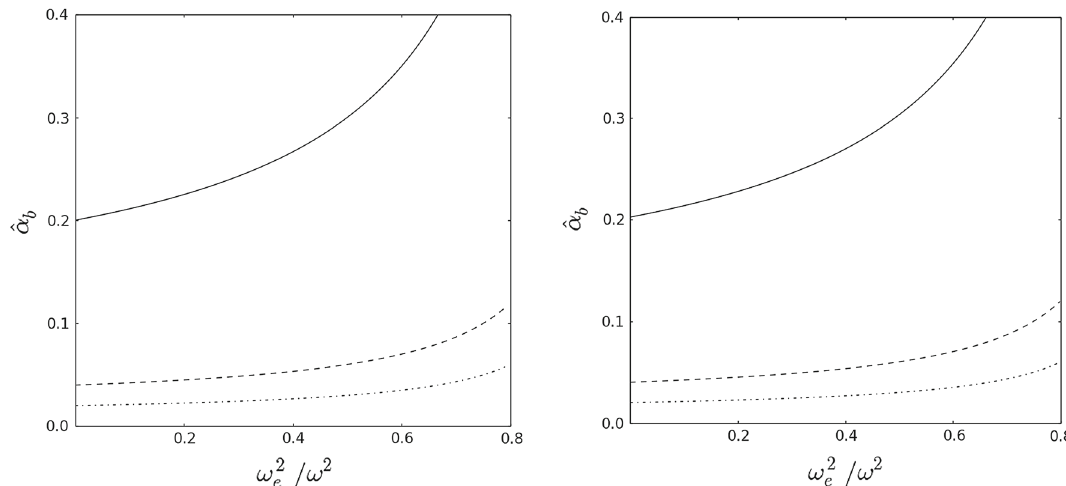
Fig. 1 Left: plot of ˆ α b vs. ω 2 e /ω 2 for b / 2 M = 10 (continuous line), b / 2 M = 50 (dashed line), and b / 2 M = 100 (dot-dashed line) for uniform plasma. Right: plot of ˆ α b vs. ω 2 e /ω 2 for the rotating case. We used different values of the impact parameter: b / 2 M = 10 (continuous